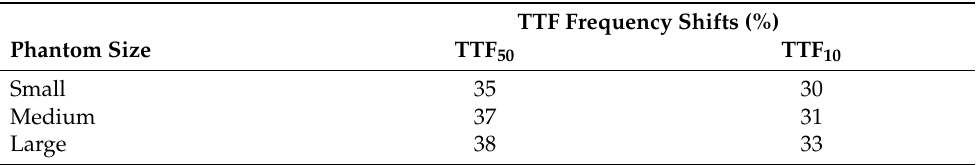
Figure 4. TTF curves obtained on a clinical EID-CT (solid lines) and a prototype PCD-CT (dashed lines) system at various phantom sizes. The area under the curve indicates spatial resolution performance. TTF—target transfer function; PCD-CT—photon-counting detector computed tomography; EID-CT—energy-integrating detector computed tomography. Table 3. TTF frequency shifts (percentage differences) for PCD-CT compared with EID-CT at the three investigated patient sizes.